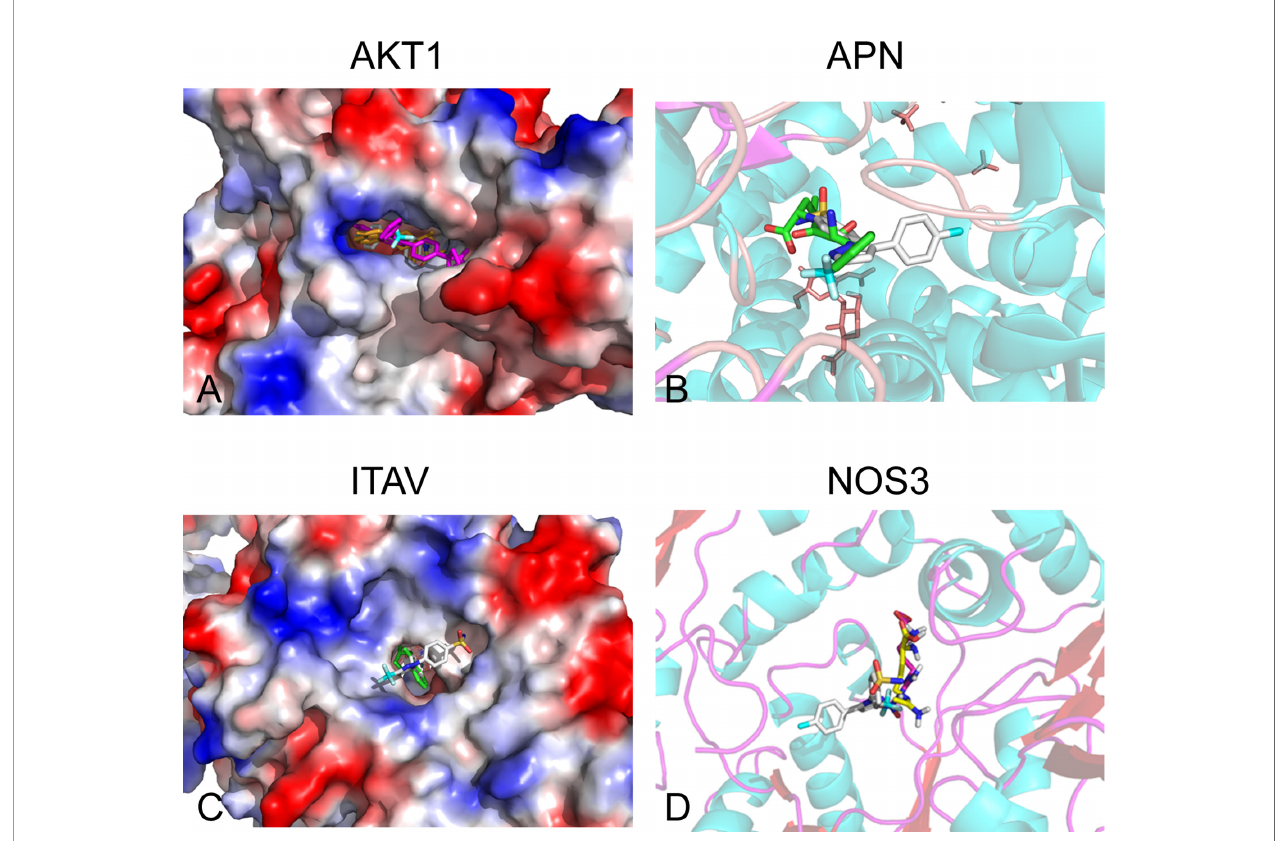
FIGURE 4 | Off-targets screening for CXB by molecular docking. Four proteins (APN, ITAV, AKT1, and NOS3) were screened as potential off-targets of CXB. (A) AKT1 was aligned with CXB and MK-2206 and AZD5363 docking structures. Rose red, MK-2206; yellow, AZD5363; white, CXB. (B) APN was compared with CXB and bestatin (BST) docking structures. Translucent, APN; green, BST; white, CXB. (C) ITAV was aligned with CXB and endostatin and rapamycin docking structures. Green, endostatin; brown, rapamycin; white, CXB. (D) NOS3 was aligned with CXB and L -NAME and L -NIO docking structures. The translucent molecule is NOS3 (4D1O); rose, L -NAME; yellow, L -NIO; and white, CXB. CXB, celecoxib; APN, aminopeptidase N; ITAV, integrin